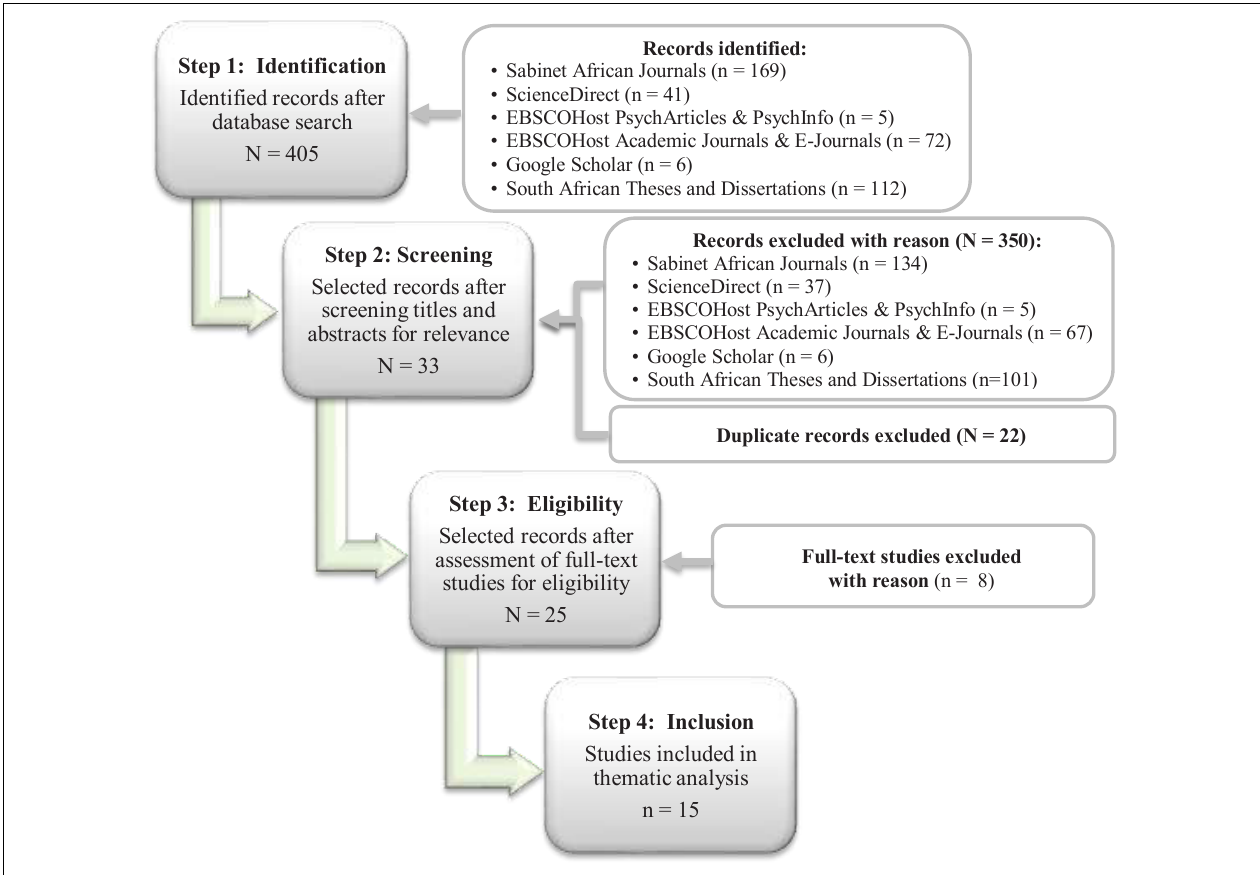
FIGURE 1 | Database search flow